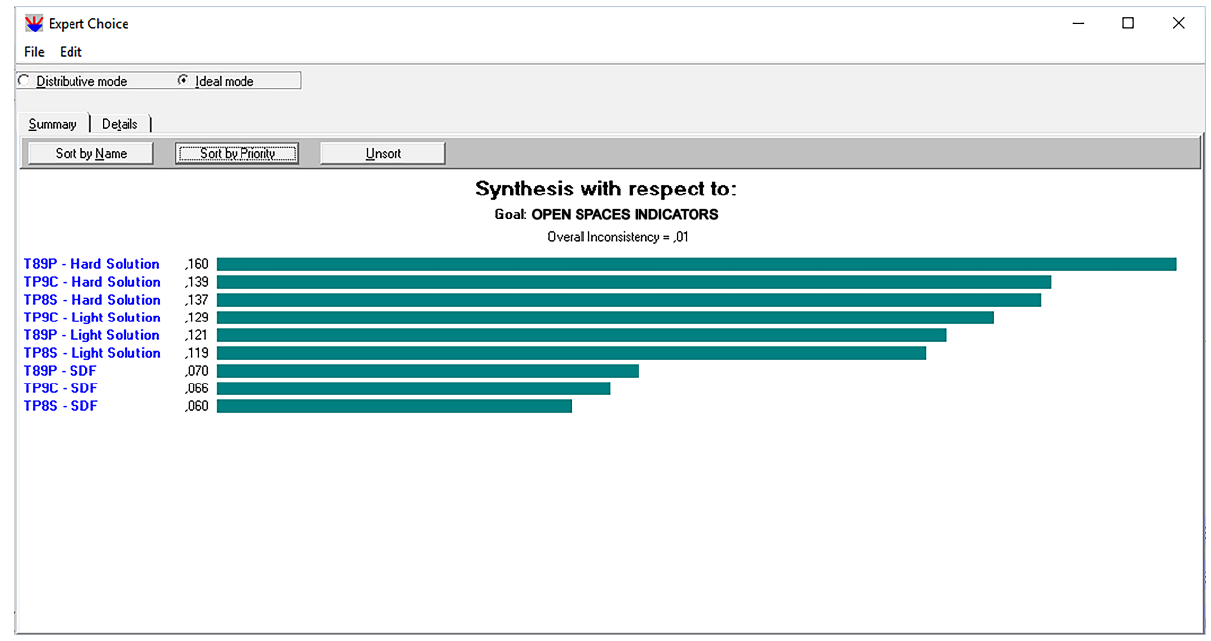
Figure 19. Preferable ranking obtained with the AHP method.